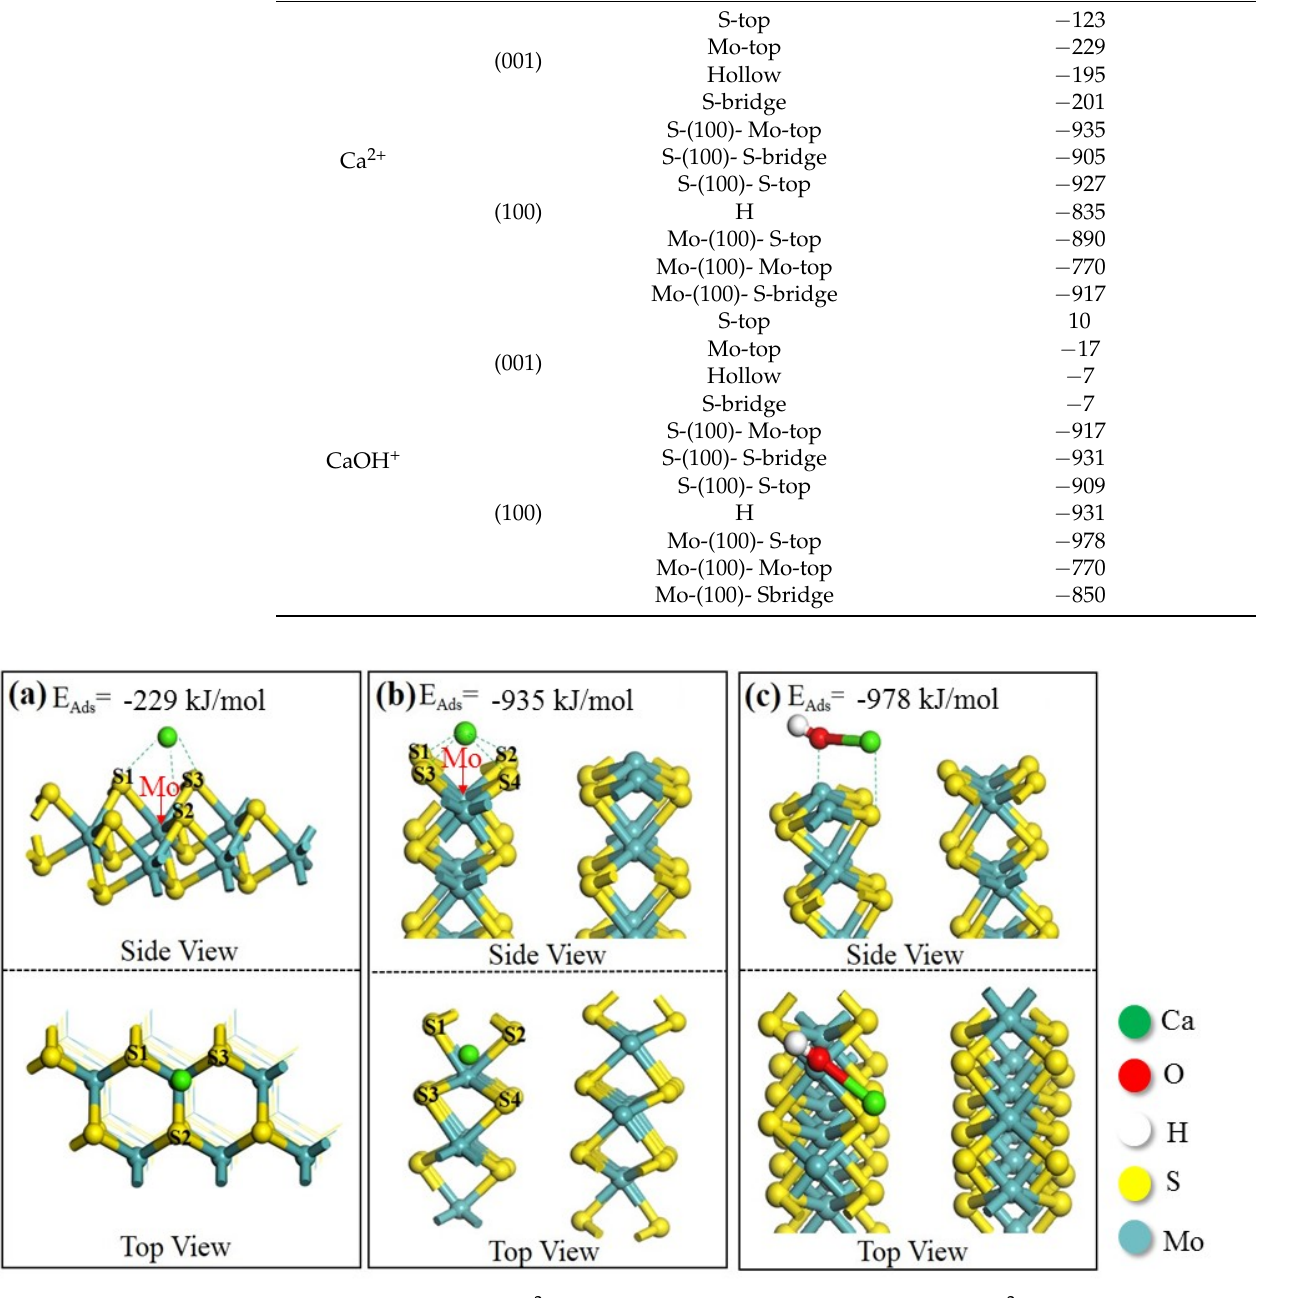
Figure 10. Optimized adsorption configuration of Ca 2+ and CaOH + on molybdenite surfaces. ( a ) Ca 2+ on Mo-top of the (001) surface; ( b ) Ca 2+ on Mo-top of S-(100) surface; ( c ) CaOH + on S-top of the Mo-(100) surface.